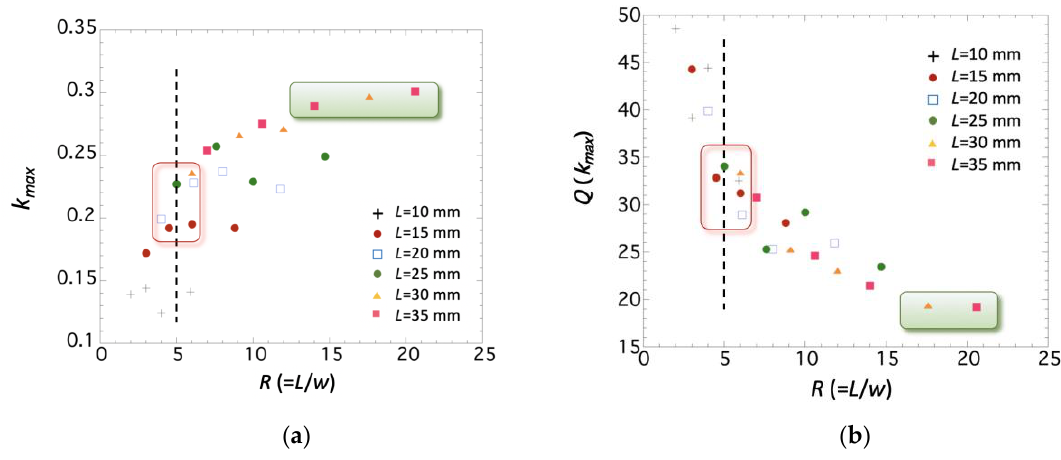
Figure 4. Measured ( a ) ΔE (%) magnitude and ( b ) 𝐻 𝑘∗ value as a function of the length-to-width ratio R , for all the measured strips.